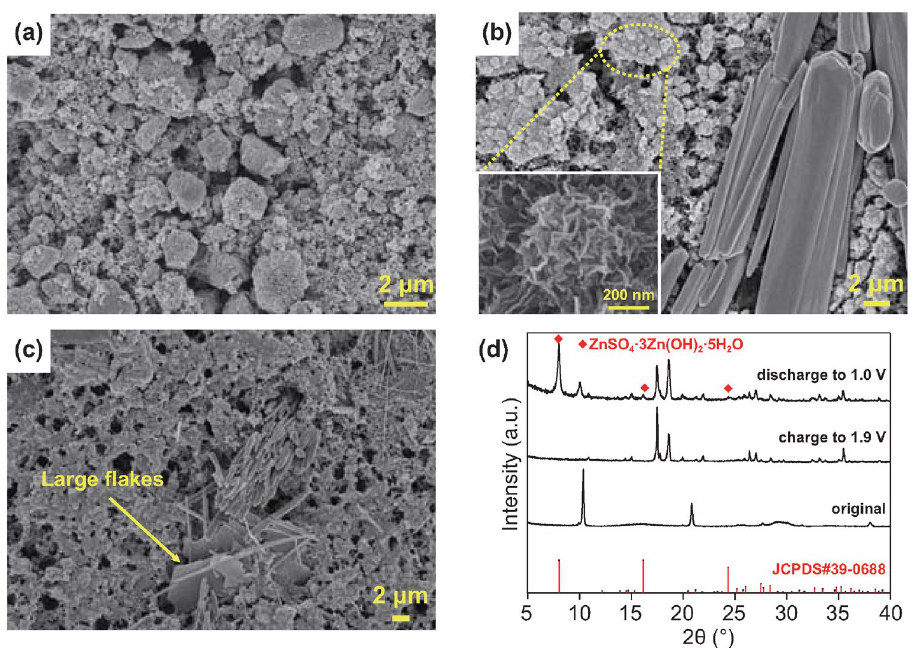
Fig. 3 SEM images of Mn(BTC) cathode at different states: a original state, b charge to 1.9 V and c discharge to 1.0 V. Inset in b is a high‑ resolution SEM image of the encircled zone. d XRD patterns of the cathode at the above